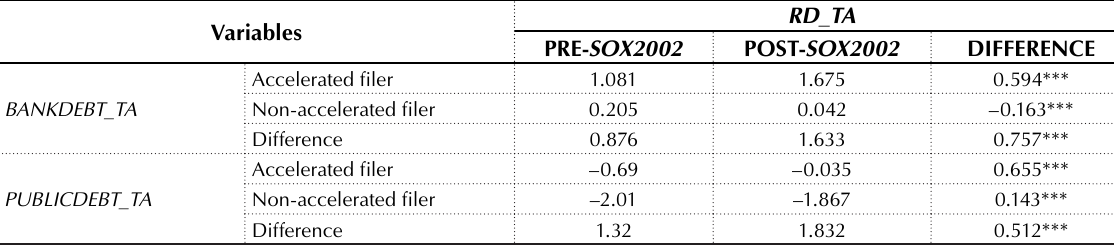
Table 5. Difference-in-differences estimation